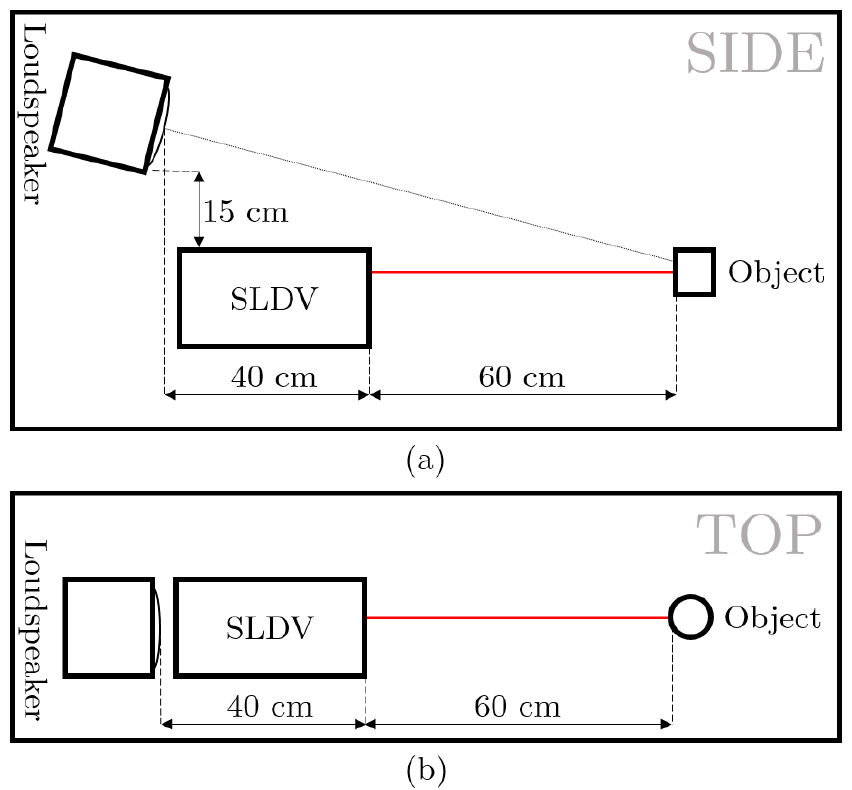
Figure A1. ( a ) side view and ( b ) top view schematic of the test apparatus with the relevant approxi- mate dimensions annotated and the measurement beam highlighted in